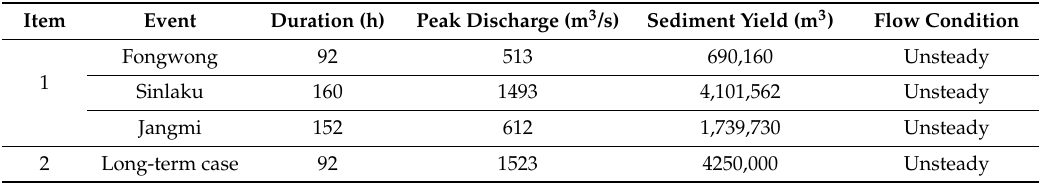
Figure 2. Inflow boundary conditions of the long-term case. Table 3. Boundary conditions of different events.